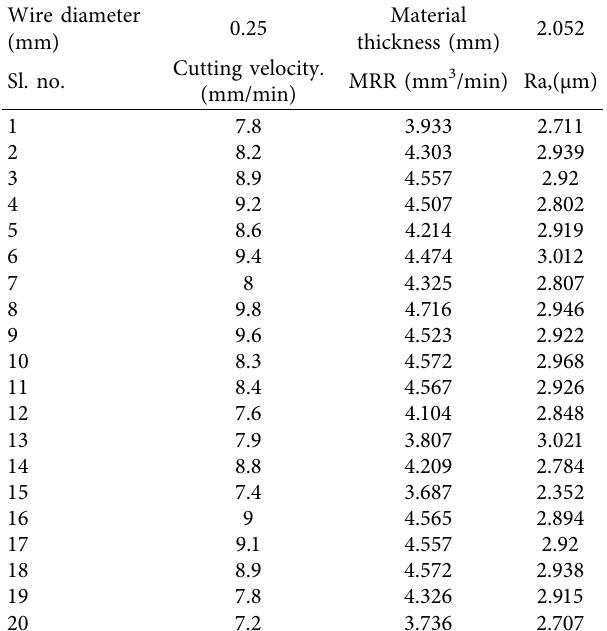
Table 6: Result of MRR and surface